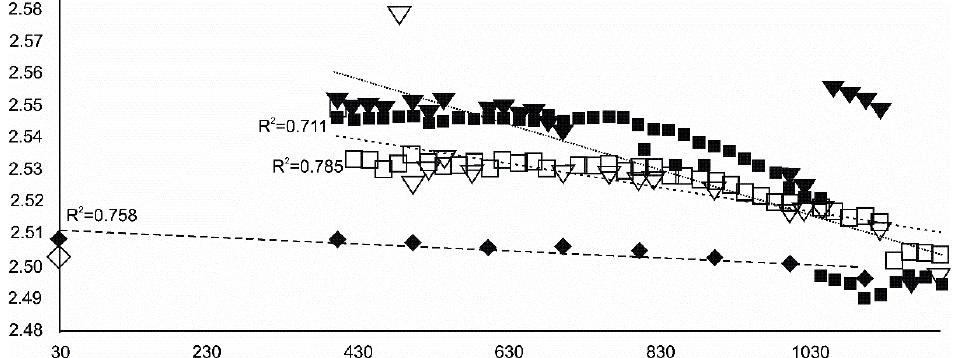
Figure 12. Relation of temperature (bottom axis, in °C) to positions of major reflections (in Å) for magnetite. LSCB sample—filled symbols. USCB sample—empty symbols. Squares—main reflection, heating. Triangles—major reflection second spinel-phase. Diamonds—main reflection, cooling. Minerals 2020 , 10 , 586 16 of 23